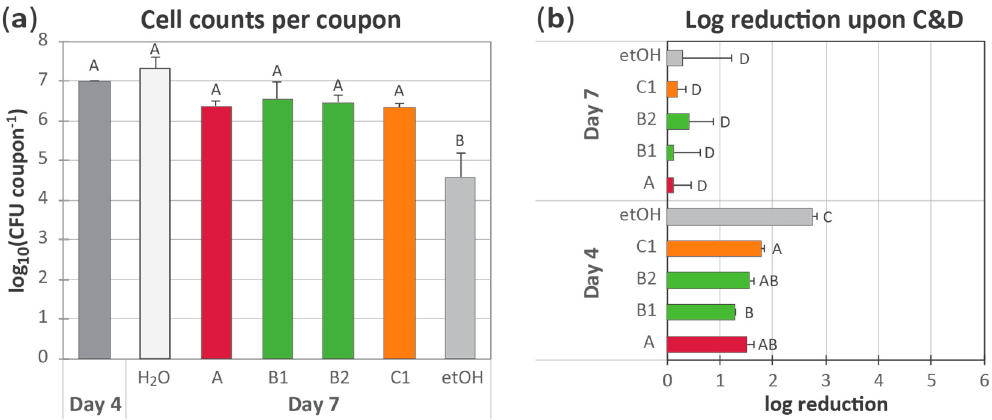
Figure 2. Biofilms of L. monocytogenes were allowed to develop undisturbed on conveyor belt coupons until day 4. Then, coupons were treated each day with either (i) rinsing in H 2 O, (ii) cleaning with cleaning agents A (2%), B1 (2%), B2 (3%), or C1 (1%), followed by disinfection with a peracetic acid (PAA)-based disinfection agent (1.5%), or (iii) incubation in 75% ethanol (etOH). ( a ) Total counts of L. monocytogenes in conveyor belt biofilms prior to treatments (Figure 1 a ; day 4) and after three consecutive days of treatments followed by 24 h of regrowth in brain heart infusion (BHI) culture medium (Figure 1 a ; day 7). ( b ) Tolerance of biofilms to treatment regimes, shown as the log reductions in bacterial counts upon C&D (or ethanol) treatment on days 4 and 7. For each experiment, the mean values of two replicates with standard errors of the means are shown. Different letters indicate a statistically different effect of treatments (confidence level 95%); in ( b ), data for days 4 and 7 were considered separately in the statistical analysis.